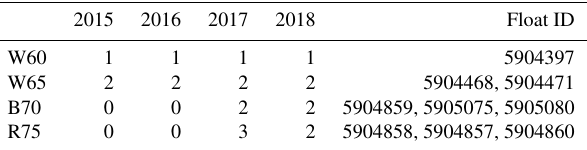
Table 1. Number of floats sampled in each year for the four study regions. This number then corresponds to the number of model runs done in each region for each of the three core experiments dis- cussed in the text. Note: W60 – Weddell Sea region at ∼ 60 ◦ S; W65 = Weddell Sea ∼ 65 ◦ S; B70 – Bellingshausen/Amundsen Sea ∼ 70 ◦ S; R75 – Ross Sea south of 75 ◦ S.